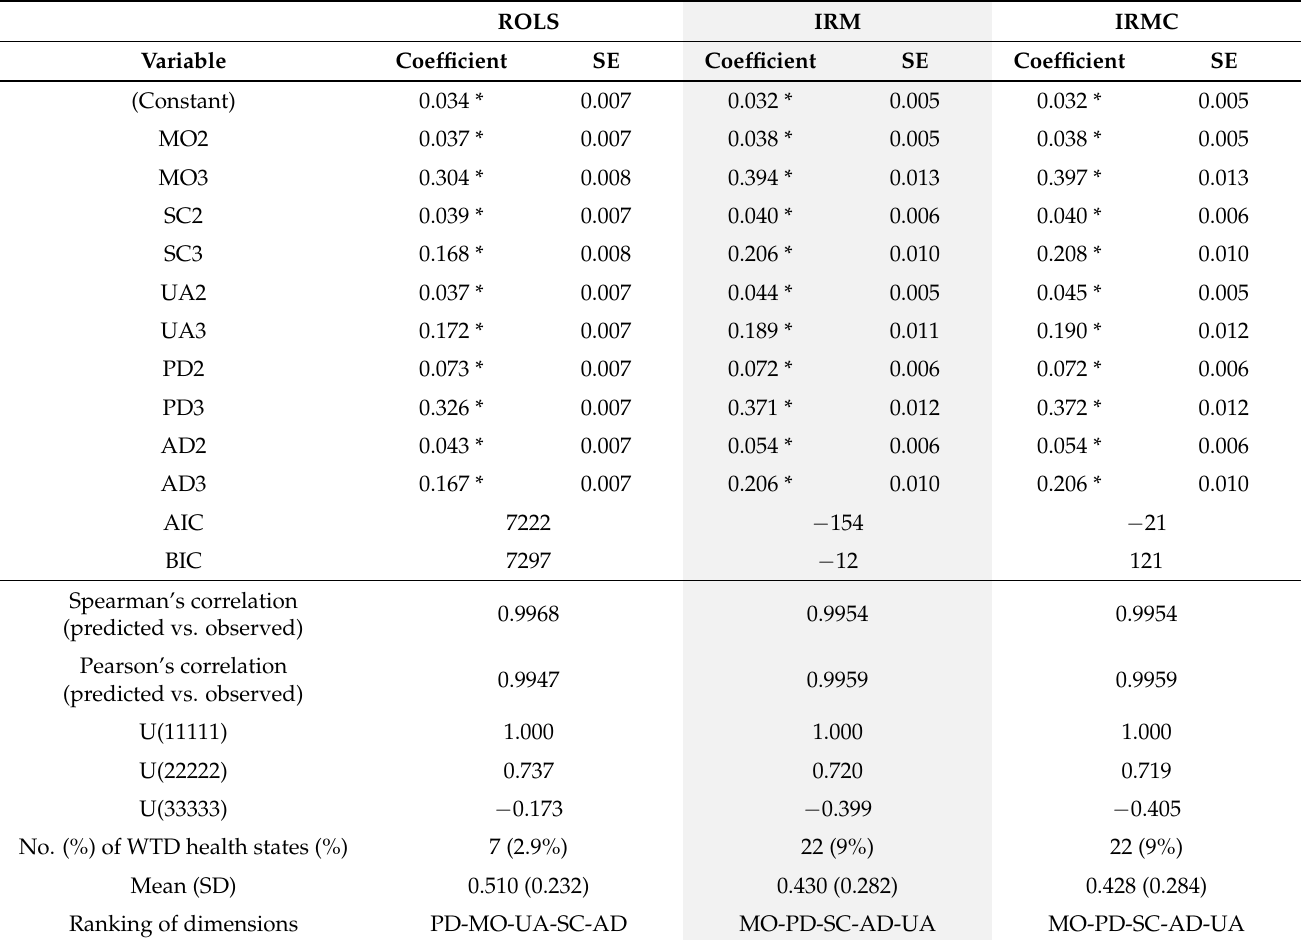
Table 4. Regression analysis results.